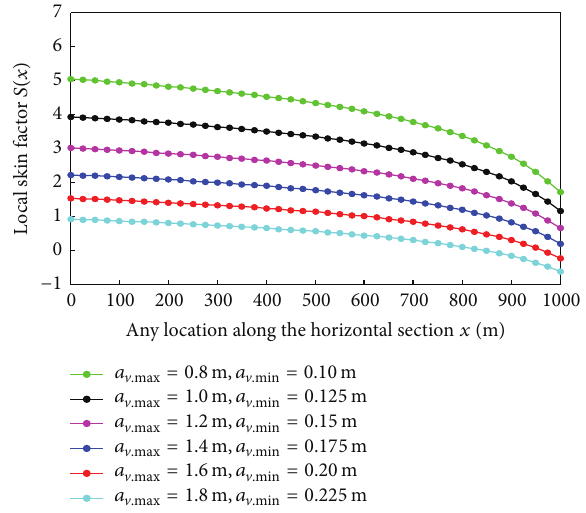
Figure 9: Effect of distance of acid-rock reaction ( 𝑎 V . max , 𝑎 V . min ) on skin factor ( 𝐿 = 1000 m, 𝑟 𝑤 = 0.1 m, 𝜀 = 0.00016 m, 𝛾 𝑔 = 0.56 , = 0.023 mPa ⋅ s, 𝑍 = 0.9 , 𝑇 = 366 K, ℎ = 10 m, 𝑝 = 20 MPa, 𝜇 𝑔 𝑤𝑓 = 0.6 mD, 𝐾 = 0.1 mD, 𝐾 = 1.2 mD, 𝐾 = 0.1 mD, 𝑑 = 𝐾 ℎ V 𝑎ℎ 𝑑ℎ V . max = 0.2 m). 1.6 m, and 𝑑 V . min